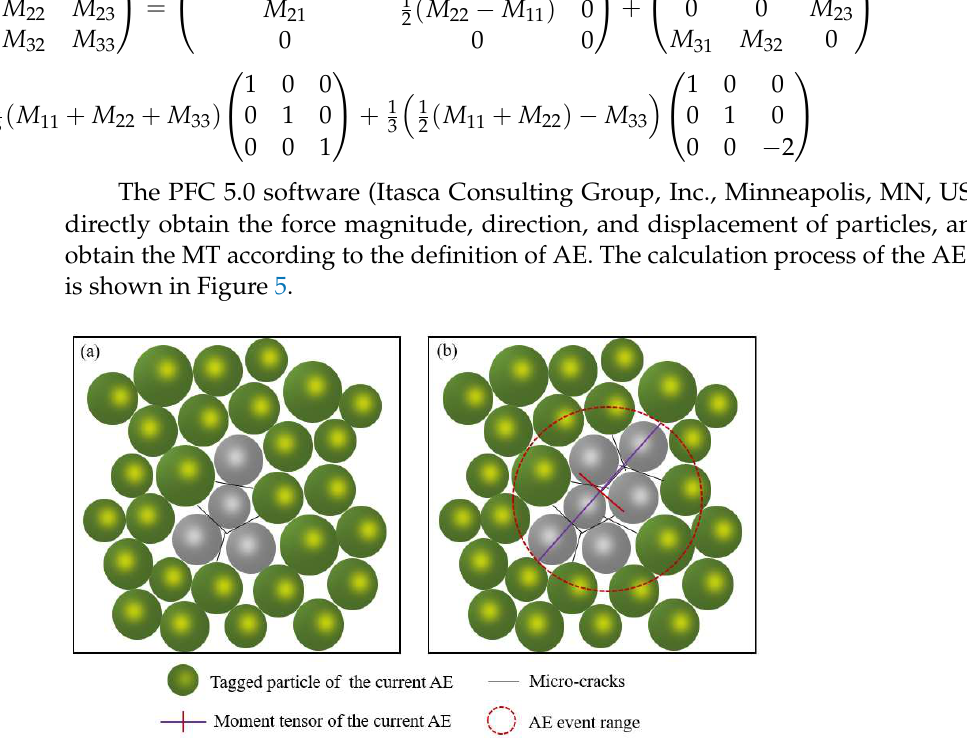
Figure 5. Generation process of an AE event: ( a ) is the start of an event and ( b ) is the finish state of this event.